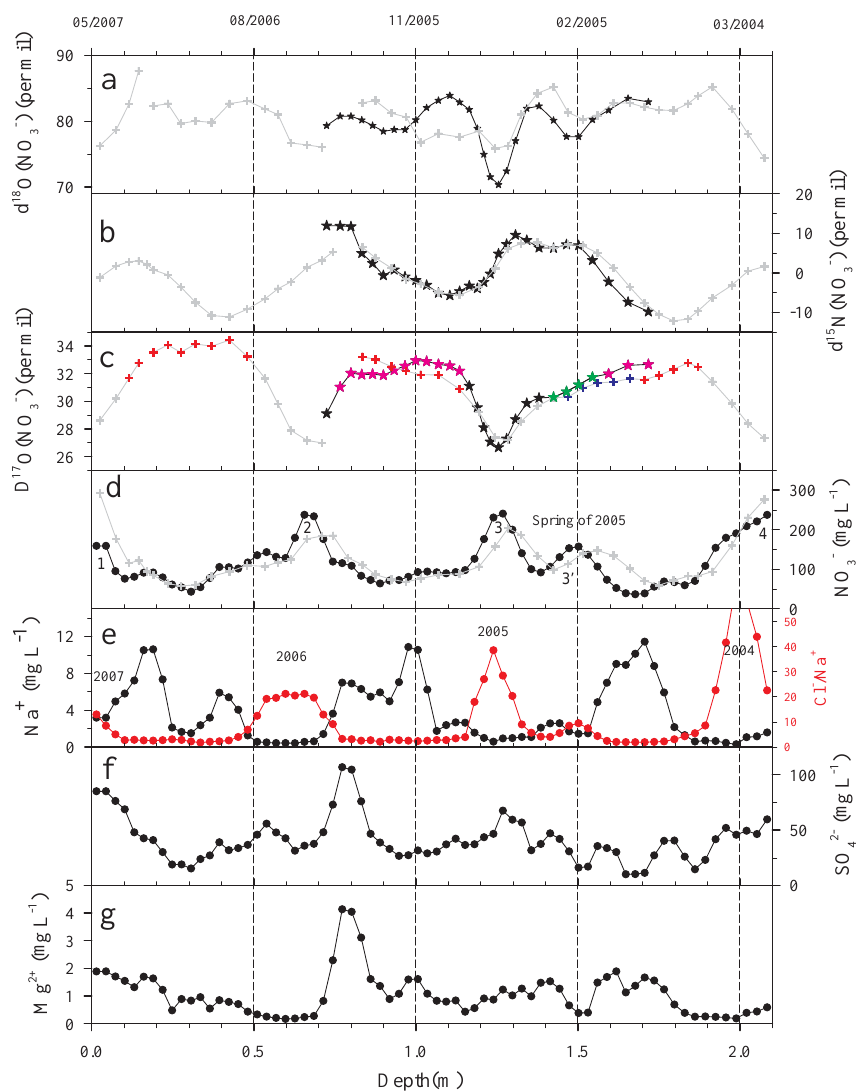
Figure 1. δ 18 O(NO − ) (a) , δ 15 N(NO − ) (b) , (cid:49) 17 O(NO − ) (c) and concentrations of NO − (d) , Na + (e) , SO 2 − (f) and Mg 2 + (g) in the 3 3 3 3 4 snow samples (data are 3-point running averages). SP-1 data were plotted in gray with plus signs; SP-2 and SB data were plotted in black with circle and star signs, respectively. The pink and green stars represent samples in SB used to calculate the winter and 2005 spring mean (cid:49) 17 O(NO − ), respectively; the red and blue plus signs represent samples in SP-1 used to calculate the winter and 2005 spring mean 3 (cid:49) 17 O(NO − ), respectively. The vertical dashed line indicates the approximate months of snowfall at depths of 0, 0.5, 1.0, 1.5 and 2.0m by 3 method B as described in the